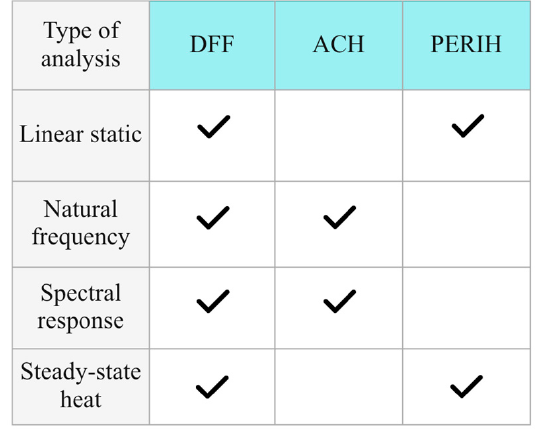
Figure 3. Types of analyses performed on each structure.